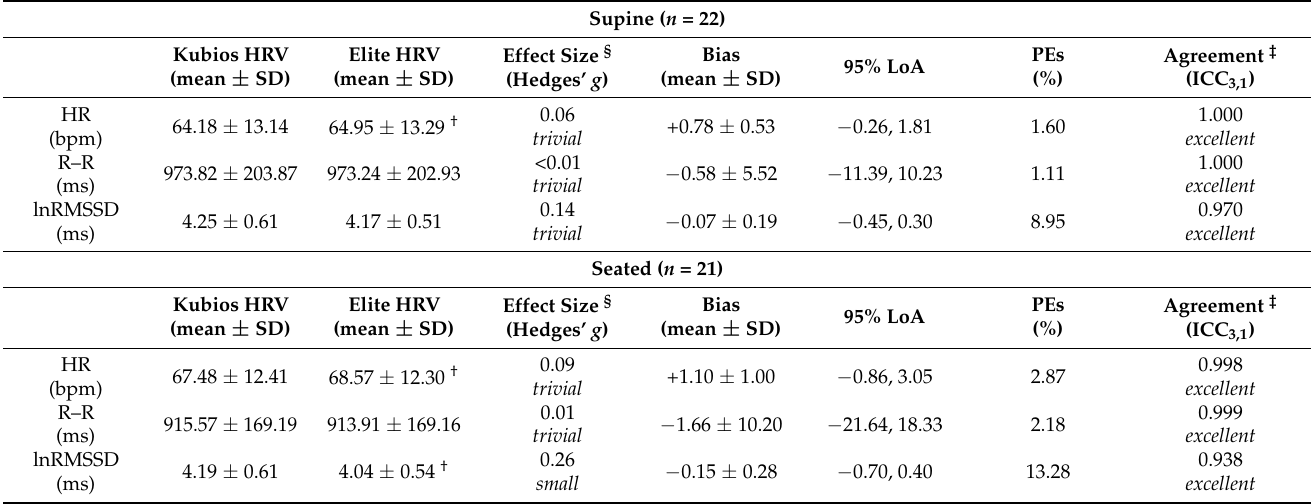
Table 1. No Correction—Descriptive data, bias, error, and agreement between software packages. Supine ( n = 22)